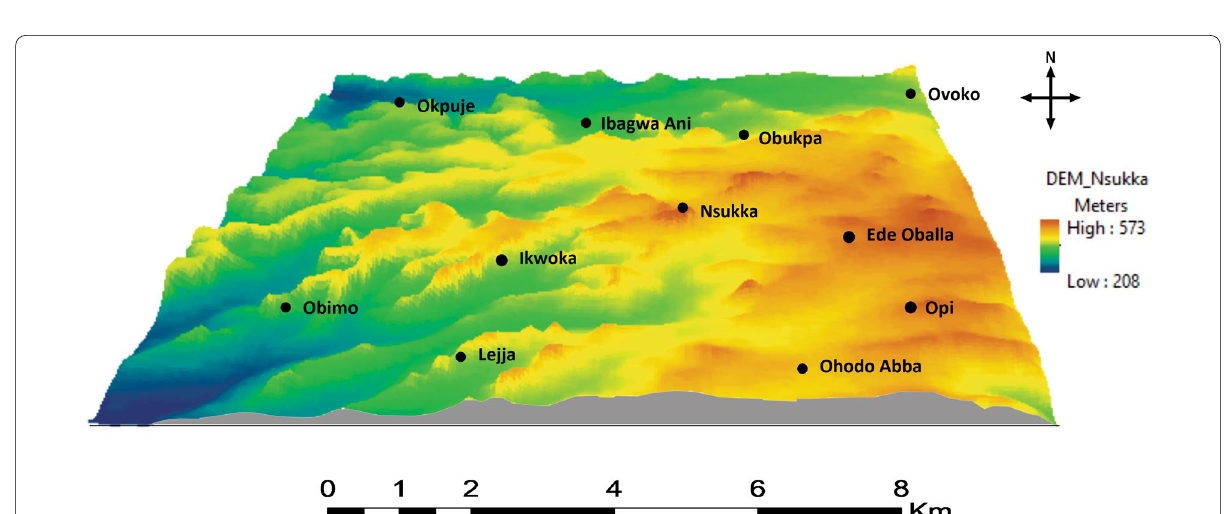
Fig. 7 Digital elevation model (DEM) of the study area where Ajali formation outcropped. Generated from NASA SRTM 30m